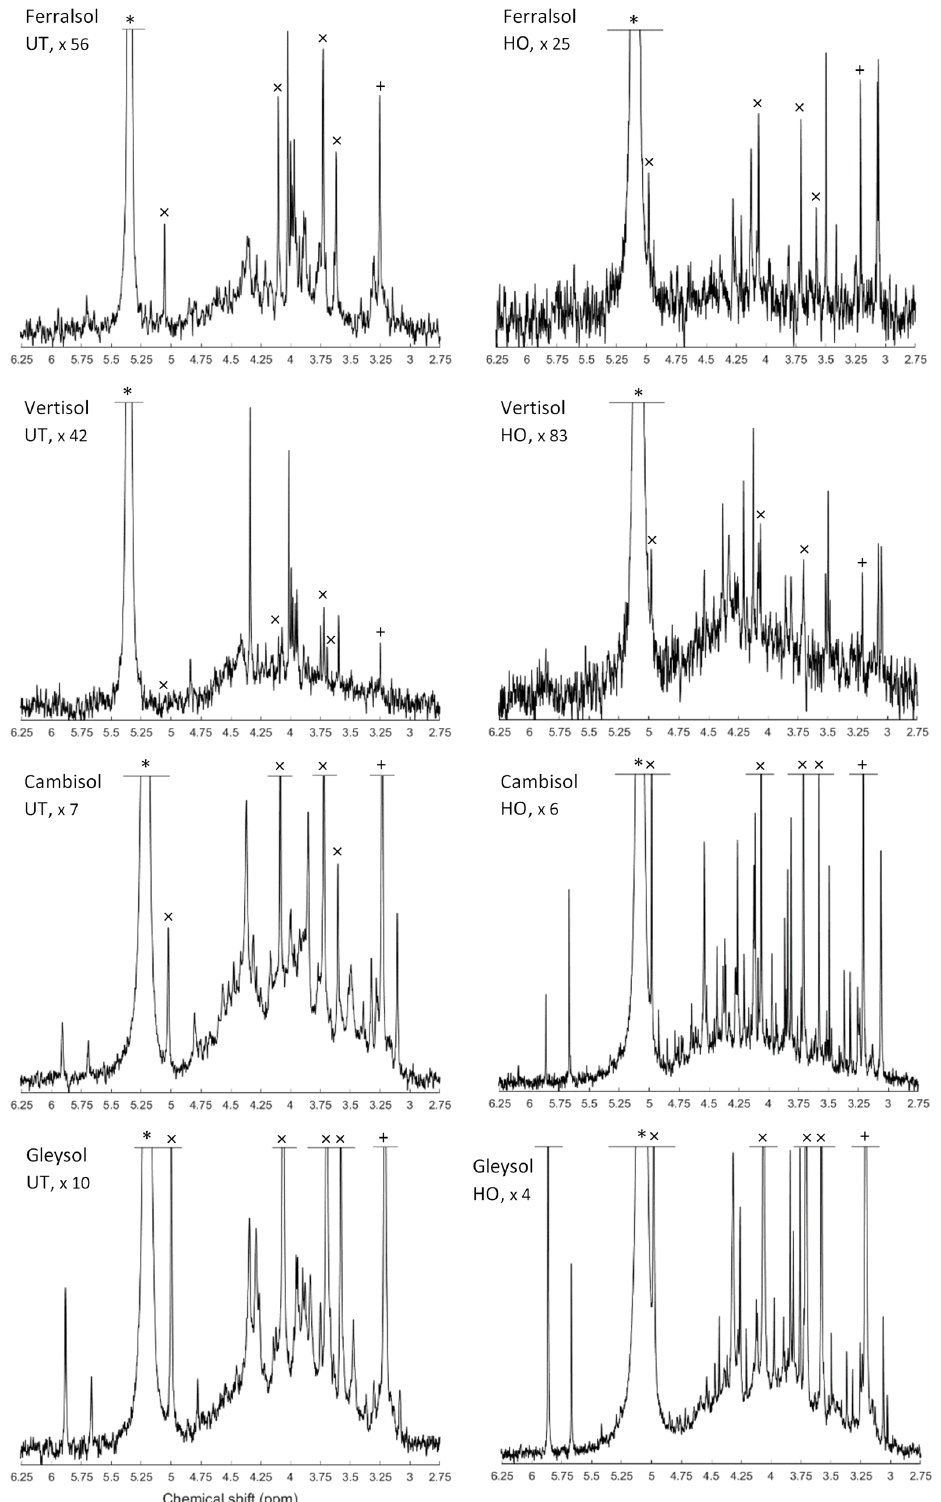
Figure 1. Solution 31 P nuclear magnetic resonance (NMR) spectra (500 MHz) of the orthophosphate and phosphomonoester region on untreated (UT) and hypobromite oxidised (HO) 0.25M NaOH + 0.05M EDTA soil extracts (Ferralsol, Vertisol, Cambisol and Gleysol). Signal intensities were normalised to the MDP peak intensity. The vertical axes were increased for improved visibility of spectral features, as indicated by a factor. The orthophosphate peak is marked with an asterisk. The symbol “ × ” marks the four individual peaks of myo -IP 6 and “ + ” the peak of scyllo -IP 6